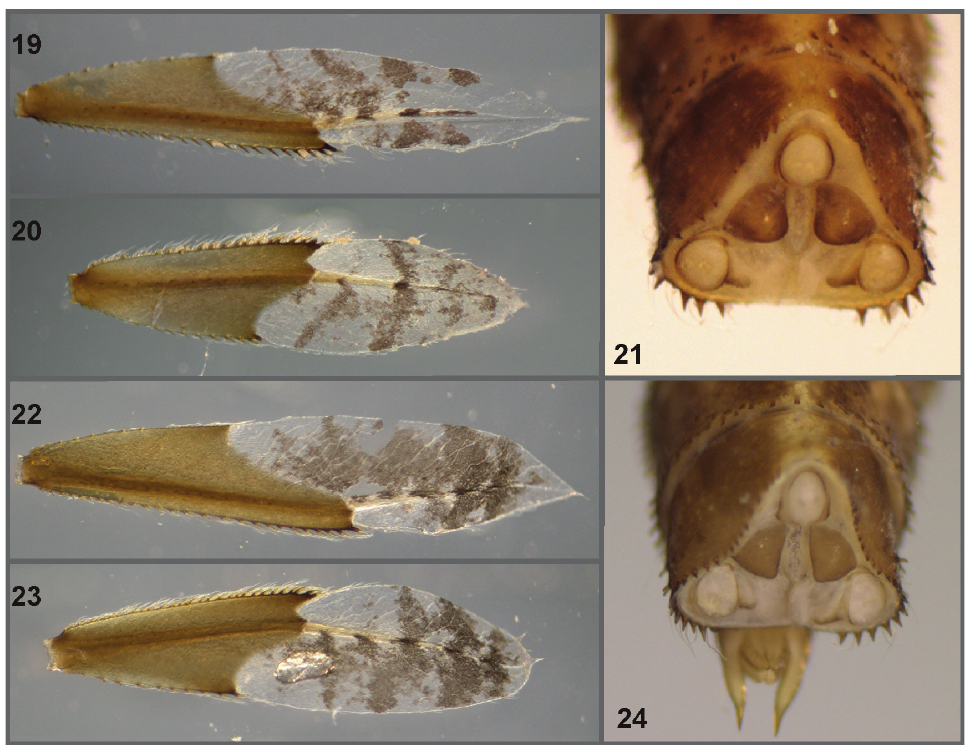
Figures 19-24 - Neoneura confundens , last instar larva. Male: 19 , lateral caudal lamella; 20 , median caudal lamella; 21 , abdominal S10 and cerci, posterior view. Female: 22 , lateral caudal lamella; 23 , median caudal lamella; 24 , abdominal S10 and cerci, posterior view.